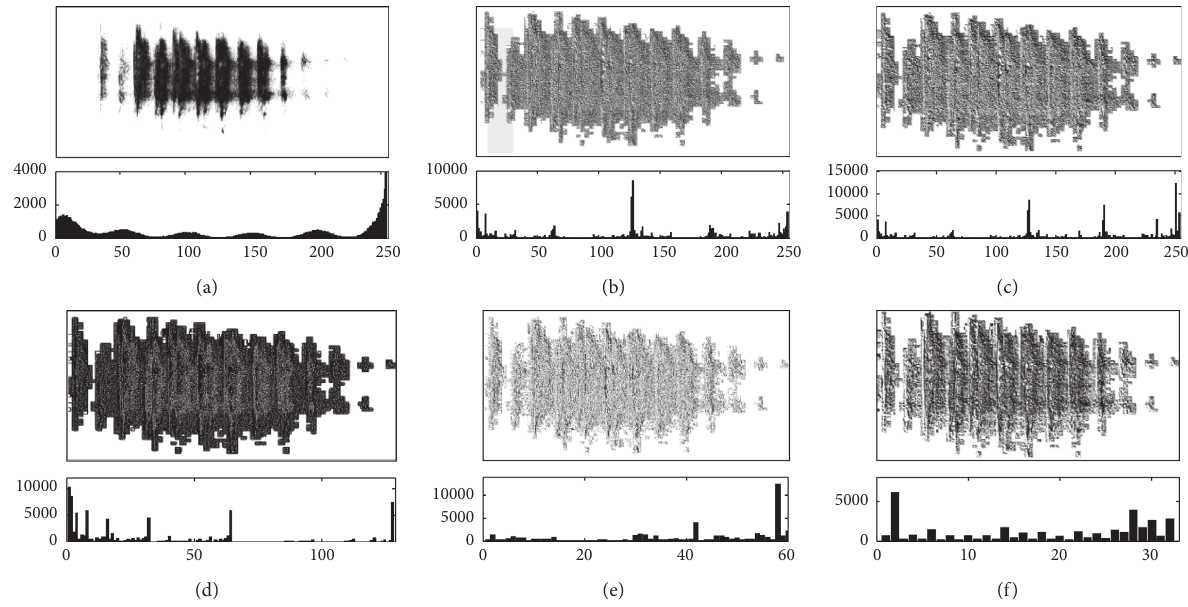
Figure 12: LBP spectrum and statistical histogram of WVD image. (a) Raw WVD image. (b) LBP. (c) Circle LBP. (d) Rotation-invariant LBP. (e) Uniform LBP. (f) ILBP.